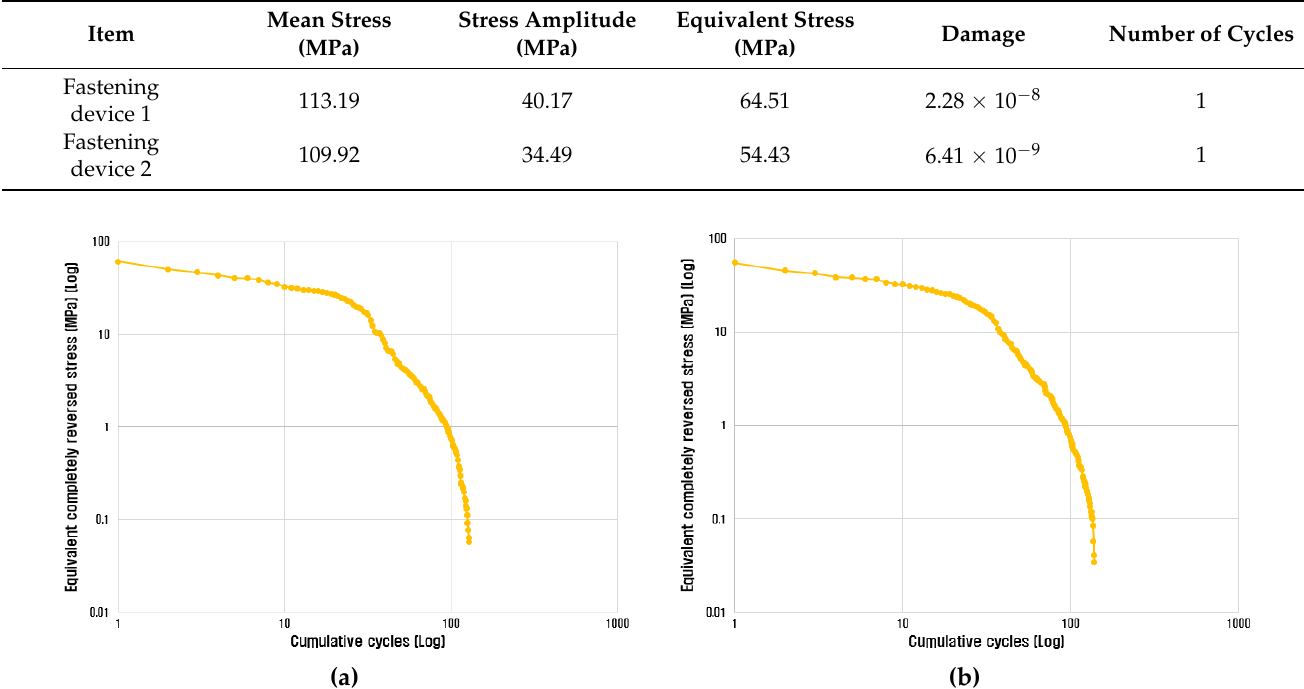
Figure 15. Load spectrum at each fastening device when loading part is lifted: ( a ) fastening device 1; ( b ) fastening device 2.